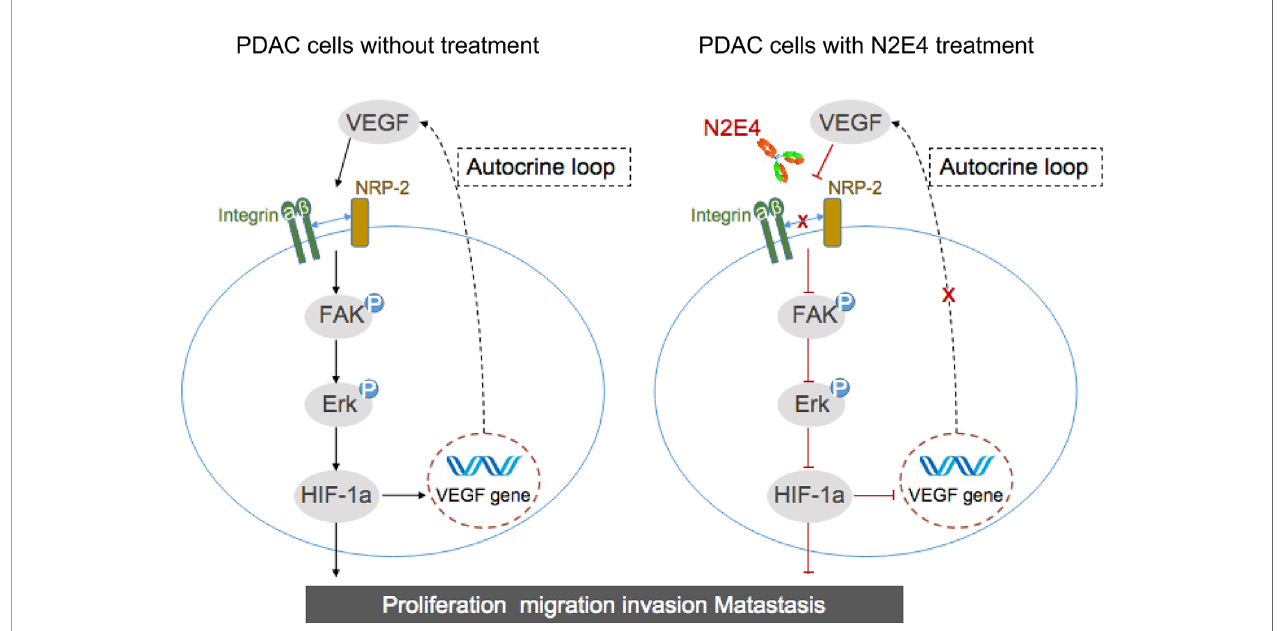
FIGURE 7 | Schematic presentation of potential mechanisms of N2E4 antibody in pancreatic cancer cells. N2E4 weakens the interaction between NRP2 and integrin b 1 by blocking NRP2, thereby inhibiting the cascade reaction of FAK/Erk/HIF-1 a , then inhibit autocrine VEGF signal transduction. This directly restrains the proliferation, migration, invasion, and metastasis, to impede the development of pancreatic